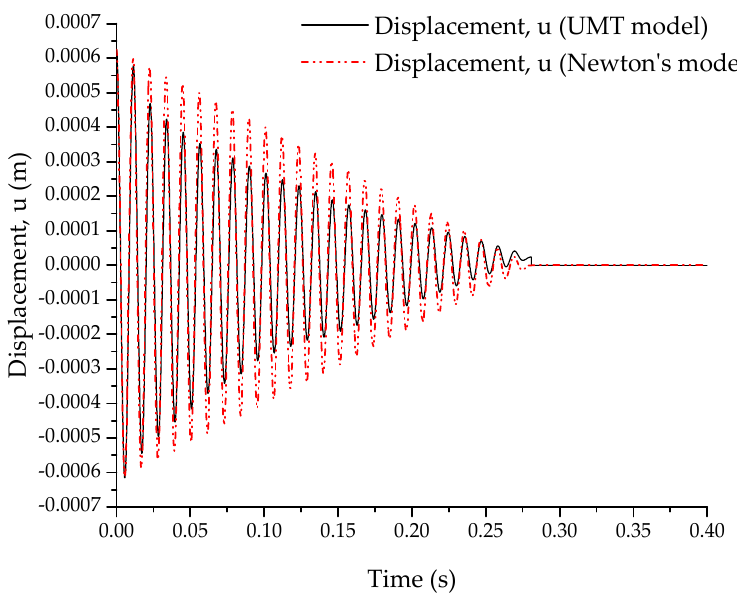
as given in Equation (38).